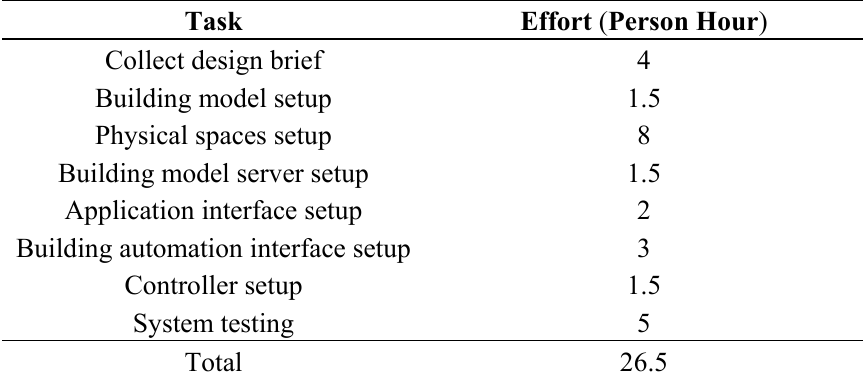
Table 3. Deployment effort for the testbed, measured in person